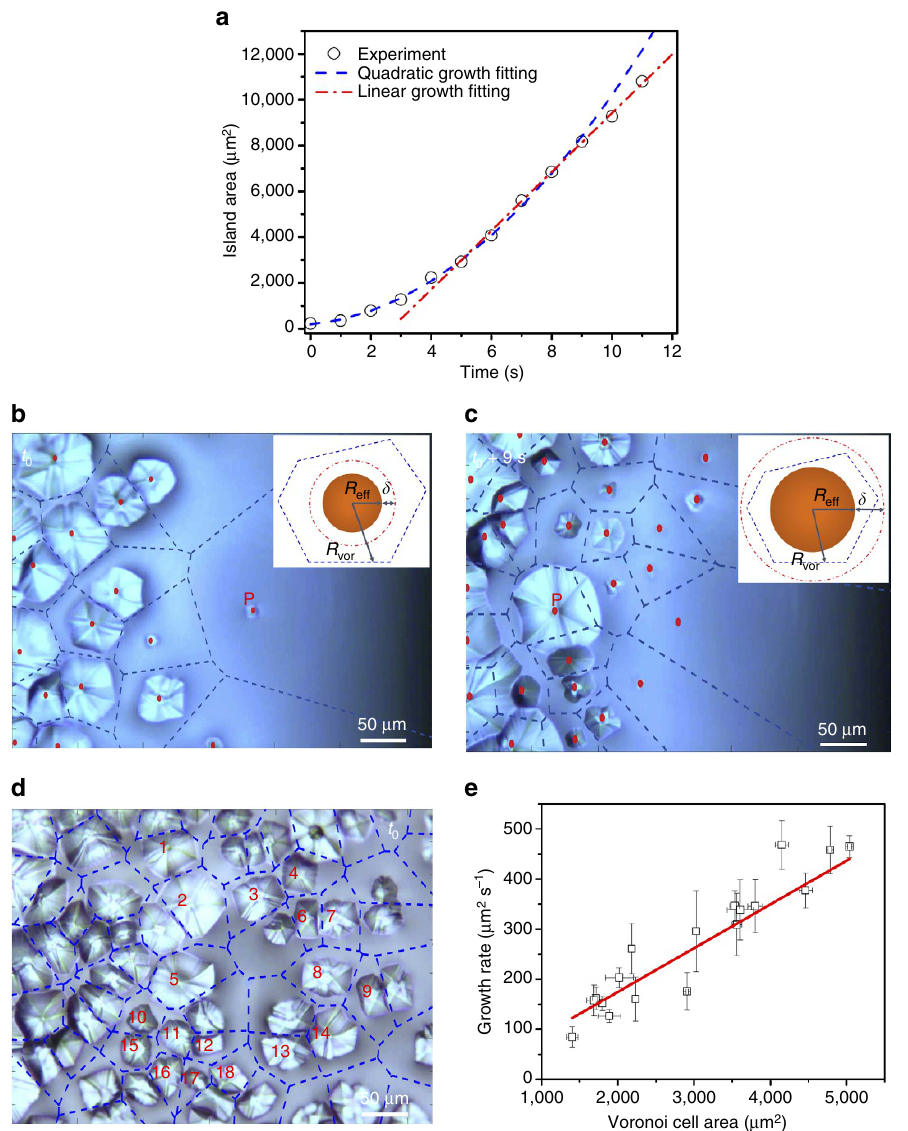
Figure 2 | Growth kinetics of FA 0.85 MA 0.15 PbI 2.55 Br 0.45 perovskite crystals during meniscus-assisted solution printing. ( a ) Plot of the area of the tracked FA 0.85 MA 0.15 PbI 2.55 Br 0.45 perovskite crystal island as a function of time. The tracked island centre is marked with P in b and c . ( b ) Voronoi cell diagram of perovskite islands at time t 0 , and the centre of the tracked island is labelled as P. The inset illustrates the topological relationship of R eff þ d o R Vor , where R eff is the effective radius of the perovskite island, d is the solute diffusion length, and R Vor is the effective radius of the corresponding Voronoi cell. ( c ) Voronoi cell diagram of perovskite islands at time t 0 þ 9 s, and the centre of the tracked island is labelled as P. The inset depicts the topological relationship of R eff þ d 4 R Vor . ( d ) Eighteen selected perovskite islands and the corresponding Voronoi cells for tracking the perovskite crystal growth rate as a function of the Voronoi cell area for each crystal island from time t 0 perovskite crystal islands as a function of their Voronoi cell areas. Error bars denote the s.d. of the data collected from time t 0